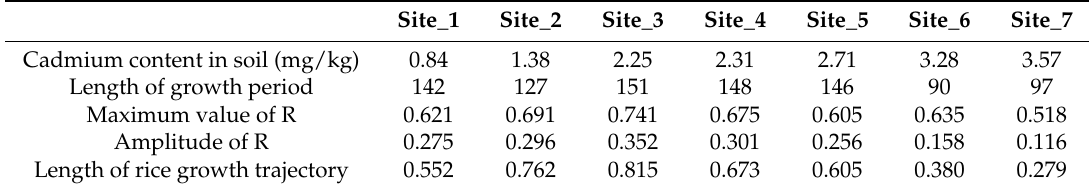
Table 3. The general rice phenological parameters in the phase space.